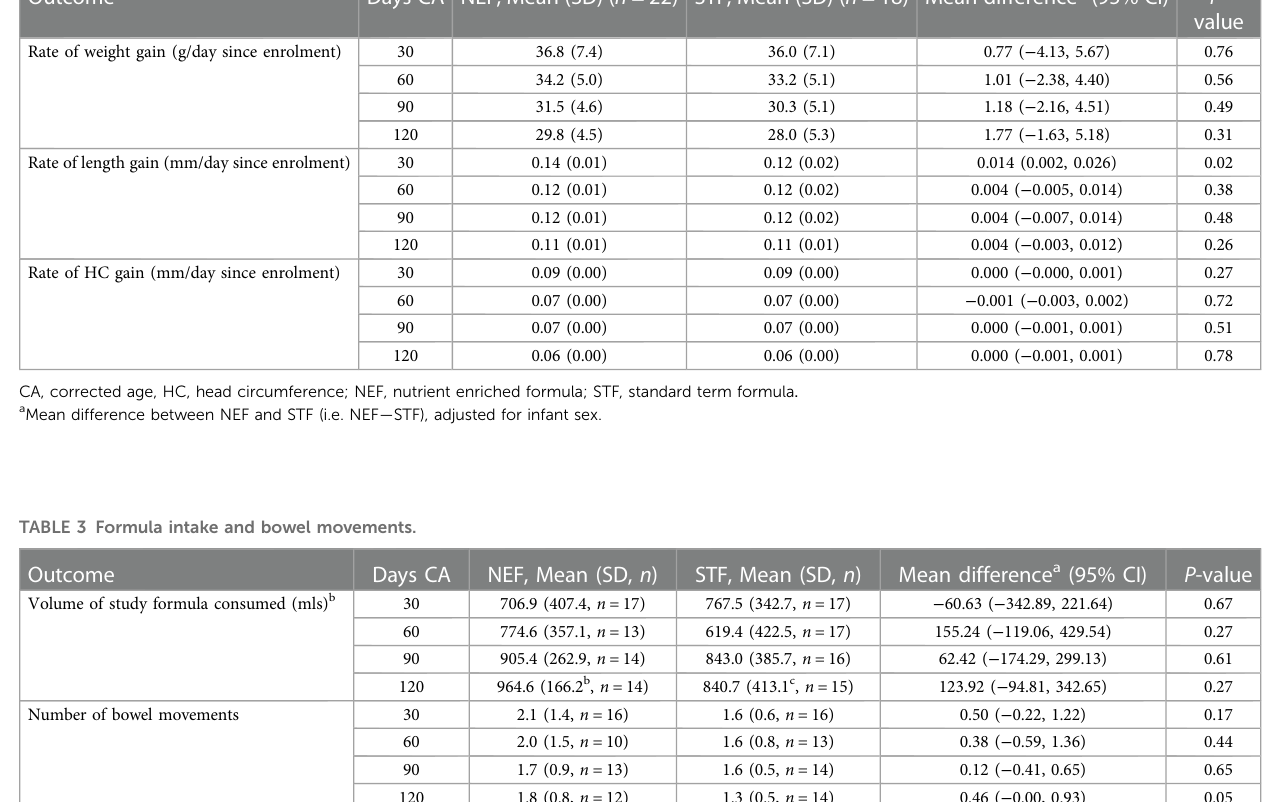
TABLE 2 Growth outcomes of randomized late-preterm infants from enrolment to 120 days CA. Outcome